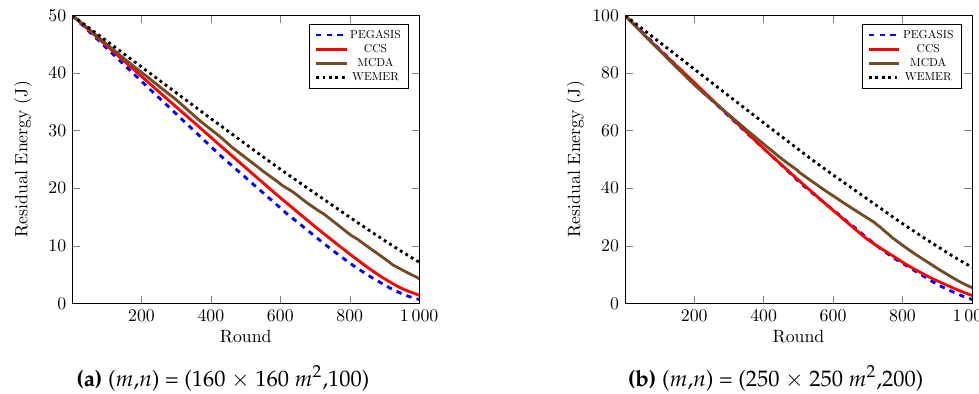
Figure 14. Residual energy of network with respect to round